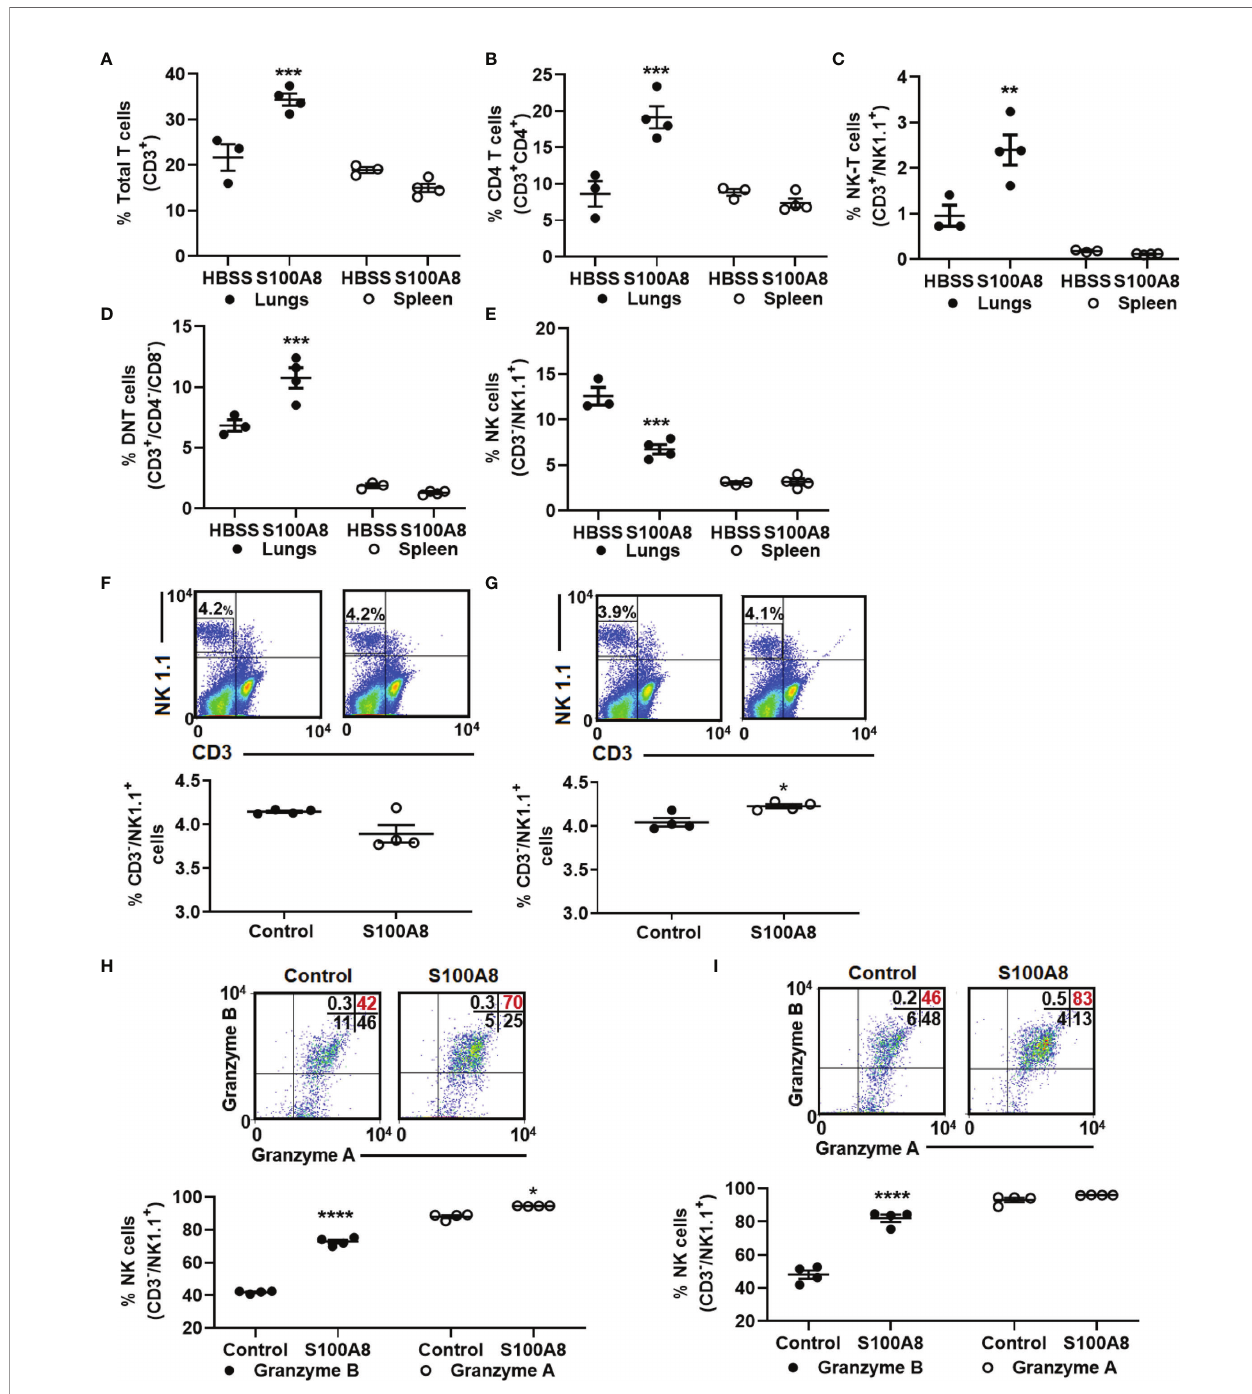
FIGURE 6 | Inhalation of S100A8 increased T cell in fi ltration into lungs of tumor-bearing mice and activated NK cells ex vivo . (A – E) Graphs showing mean percentages ± SEM of total T cells (CD3 + ) (A) , CD4 T cells (CD3 + /CD4 + ) (B) , NK-T cells (CD3 + /NK1.1 + ) (C) , double-negative T cells (CD3 + /CD4 - /CD8 - ) (D) and NK cells (CD3 - /NK1.1 + ) (E) in lungs and spleens from tumor-bearing mice treated with recombinant S100A8 or HBSS (controls) on Days 3, 6 and 9 post-LLC cell implantation and harvested on Day 10, n = 3-4 mice per treatment group, **p < 0.01 and ***p < 0.001, (F, G) Flow cytometry diagrams and graphs showing mean percentages ± SEM of NK cells isolated from splenocytes from four individual mice (F) 24 and (G) 48 hours after ex-vivo treatment with recombinant S100A8 (10 µg/ml), *p < 0.05. (H, I) Flow cytometry diagrams and graphs showing mean percentages ± SEM of NK cells expressing granzyme A and granzyme B (H) 24 and (I) 48 hours after ex-vivo treatment with recombinant S100A8 (10 µg/ml), ****p <